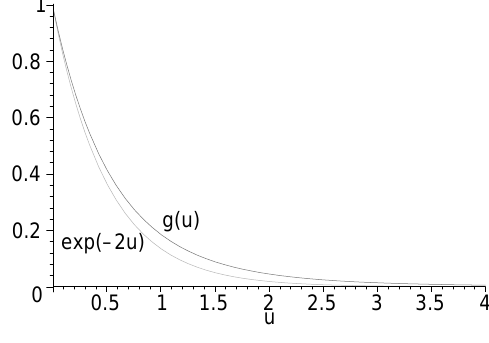
FIG. 4. Penetration function g (cid:1) u (cid:2) and e 2 2 u